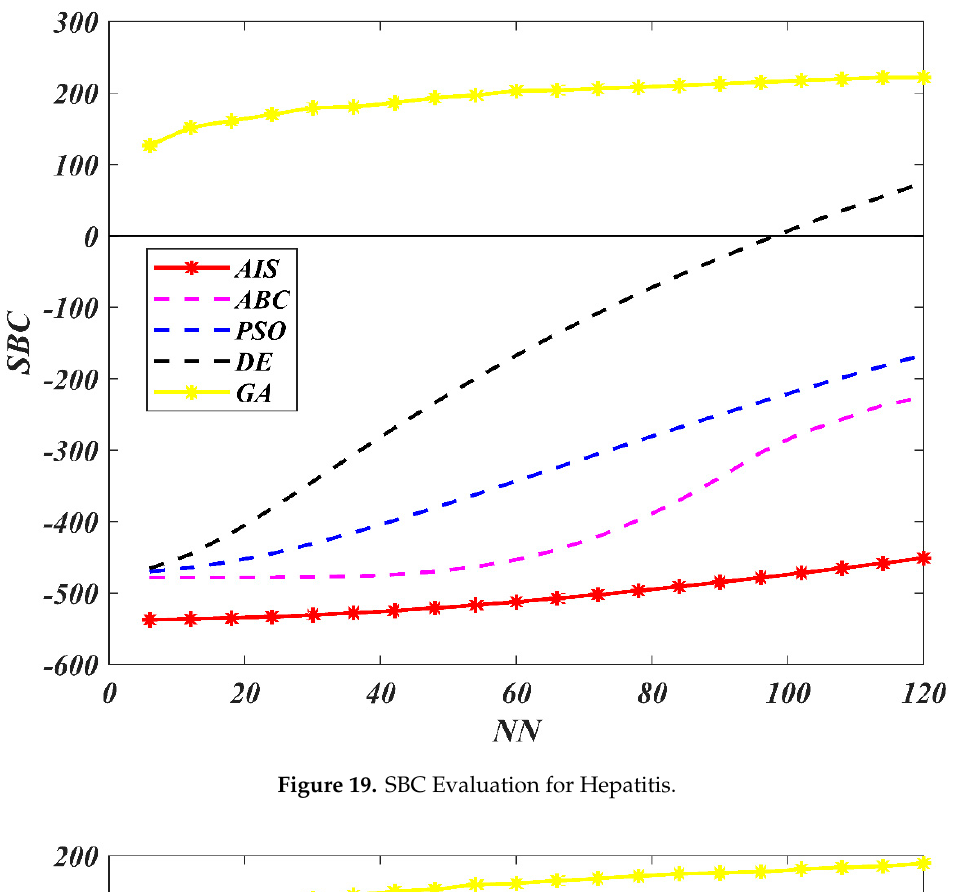
Figure 18. Schwarz Bayesian Criterion (SBC) Evaluation for German Credit.